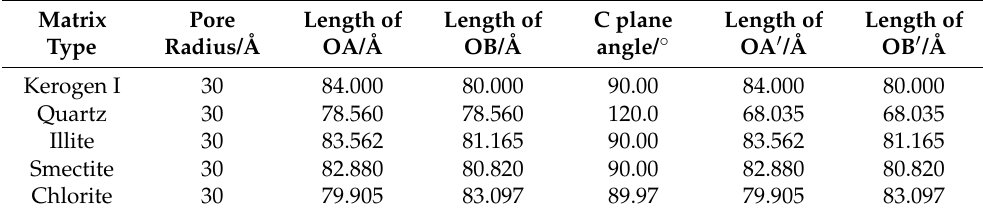
Figure 1. Schematic diagram of 60Å pore model. ( a ). XY direction; ( b ). Z direction. Table 1. Geometry parameters of pore